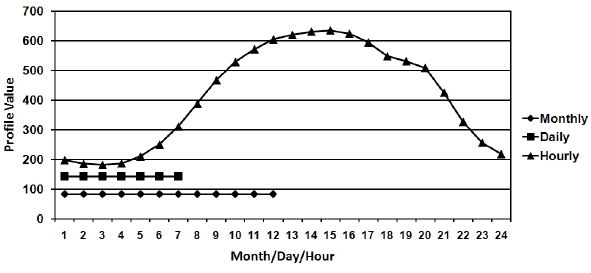
Fig. A4. SMOKE v2.5 default hourly temporal profile for natural sources applied to sulfur emissions from ocean, coastal wetland, freshwater, the Great Salt Lake, and geothermal sources. Default monthly and daily temporal allocation profiles are also shown.